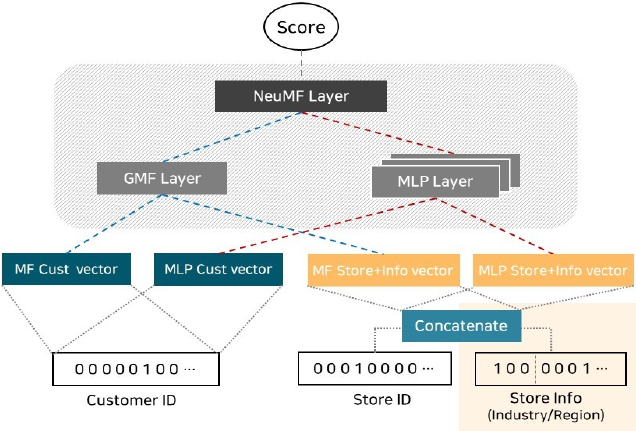
Figure 5. Structure of NMF with Store Information (NMF_SI).